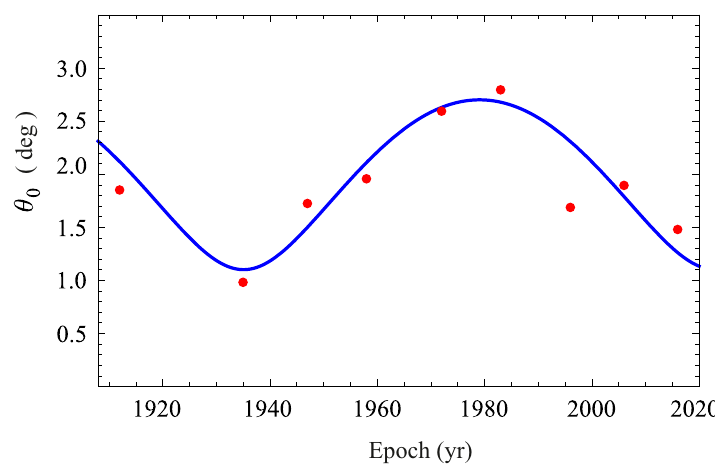
Figure 9. Changes of the angle between the jet helix axis with the line of sight θ 0 due to the precession of the OJ 287